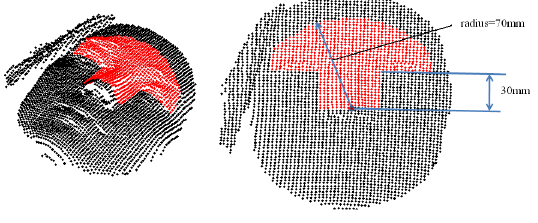
Fig. 13. When apply the ICP algorithm, only the points within the red region of the target model are used.